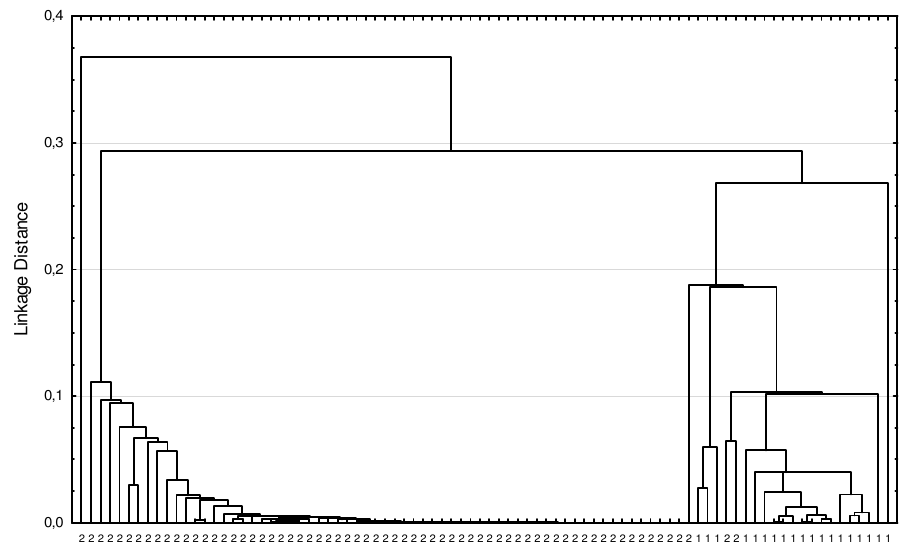
Figure 1. Cluster analysis of the studied